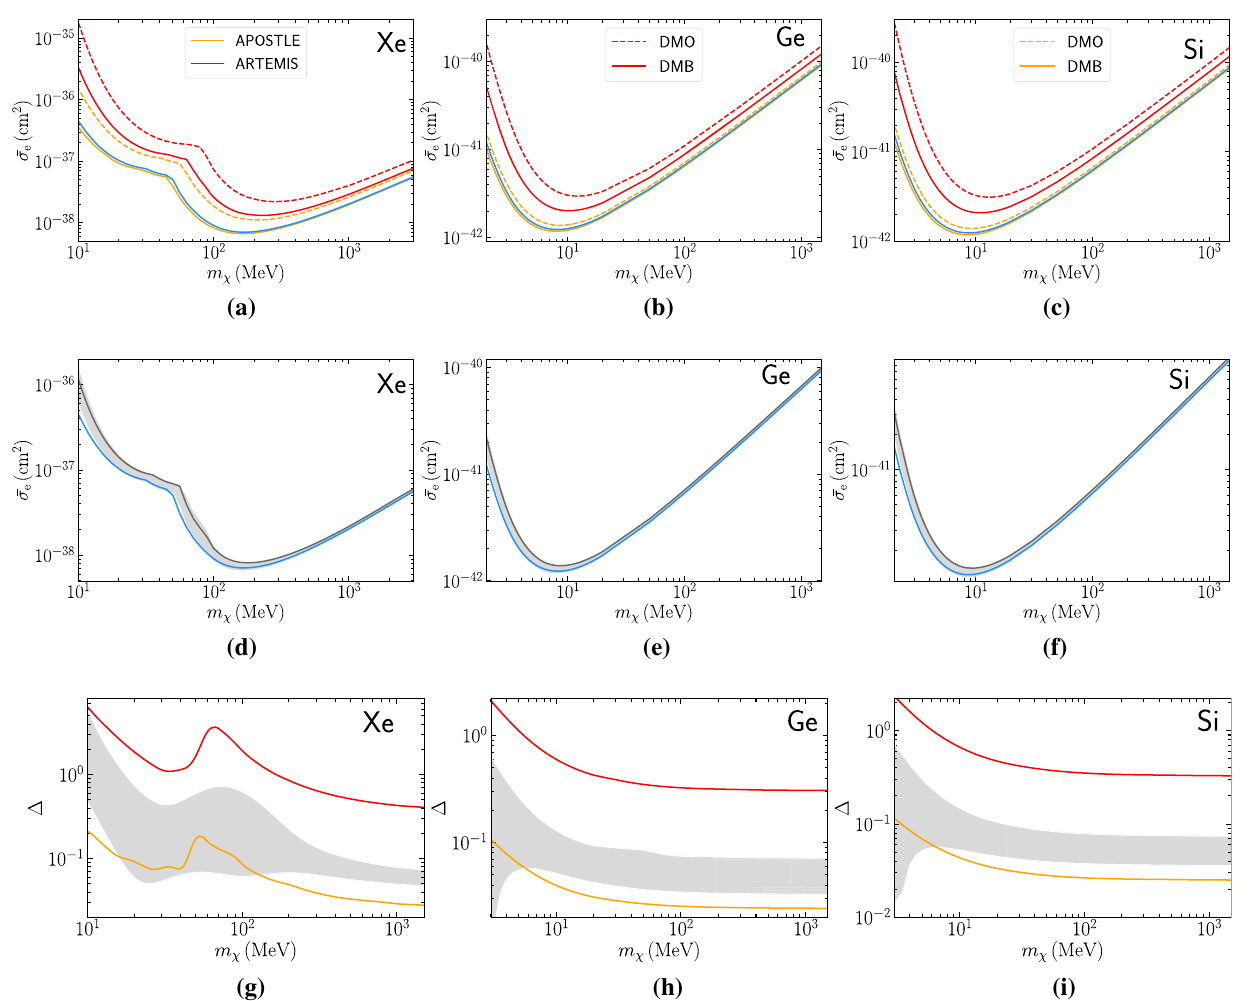
Fig. 3 VariationsintheexclusionboundsfortheKingdistributionwith F DM = 1. In the upper panel the orange and red exclusion lines corre- spond to the APOSTLE and ARTEMIS simulations respectively with best-fit values from Table 2. In the middle panel we show the exclusion bounds using King distribution with astrophysical parameters obtained from recent observations. The shaded bands represent observational error at the 95% confidence level. The solid light blue and grey lines